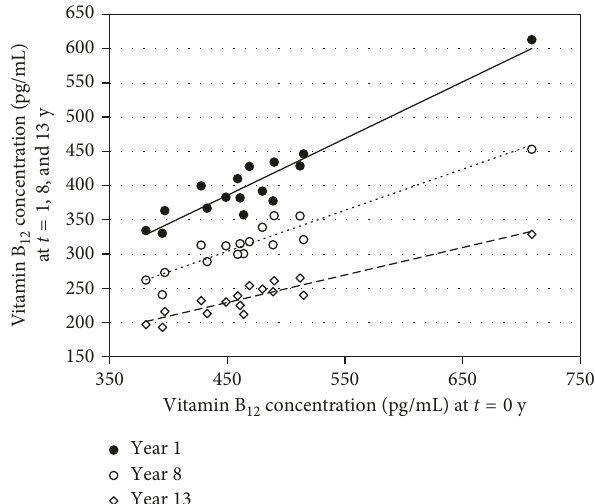
Figure 4: Correlation between the mean vitamin B tions at t � 0 and after storage for 1, 8, and 13 years at − 70 ° C. The correlation lines have the following equations: y � 0.829 x +2.80 , y � 0.600 x +33.7 , and y � 0.401 x +48.5 for 1, 8, and 13years, respectively.